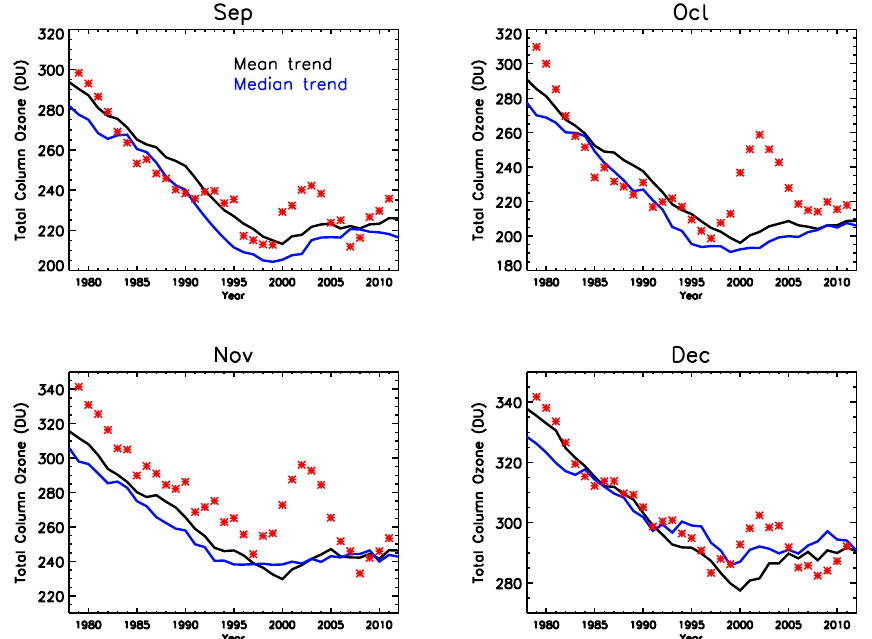
Fig. 2. Multi-model median (blue) and mean (black) TOC time series in comparison with TOMS observations during the 1979–2011 period. Both datasets have been smoothed with a 5yr uniformly weighted sliding mean